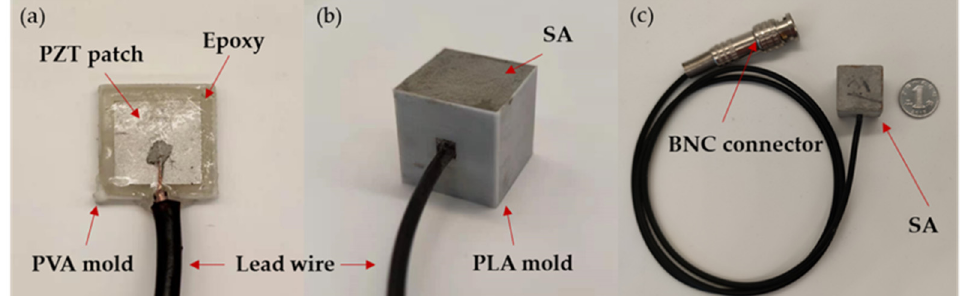
Figure 3. ( a ) PZT patch covered with an epoxy resin layer in a PVA mold; ( b ) Cement mortar with the epoxy resin-wrapped PZT patch cast in a PLA mold; ( c ) A photo of a smart